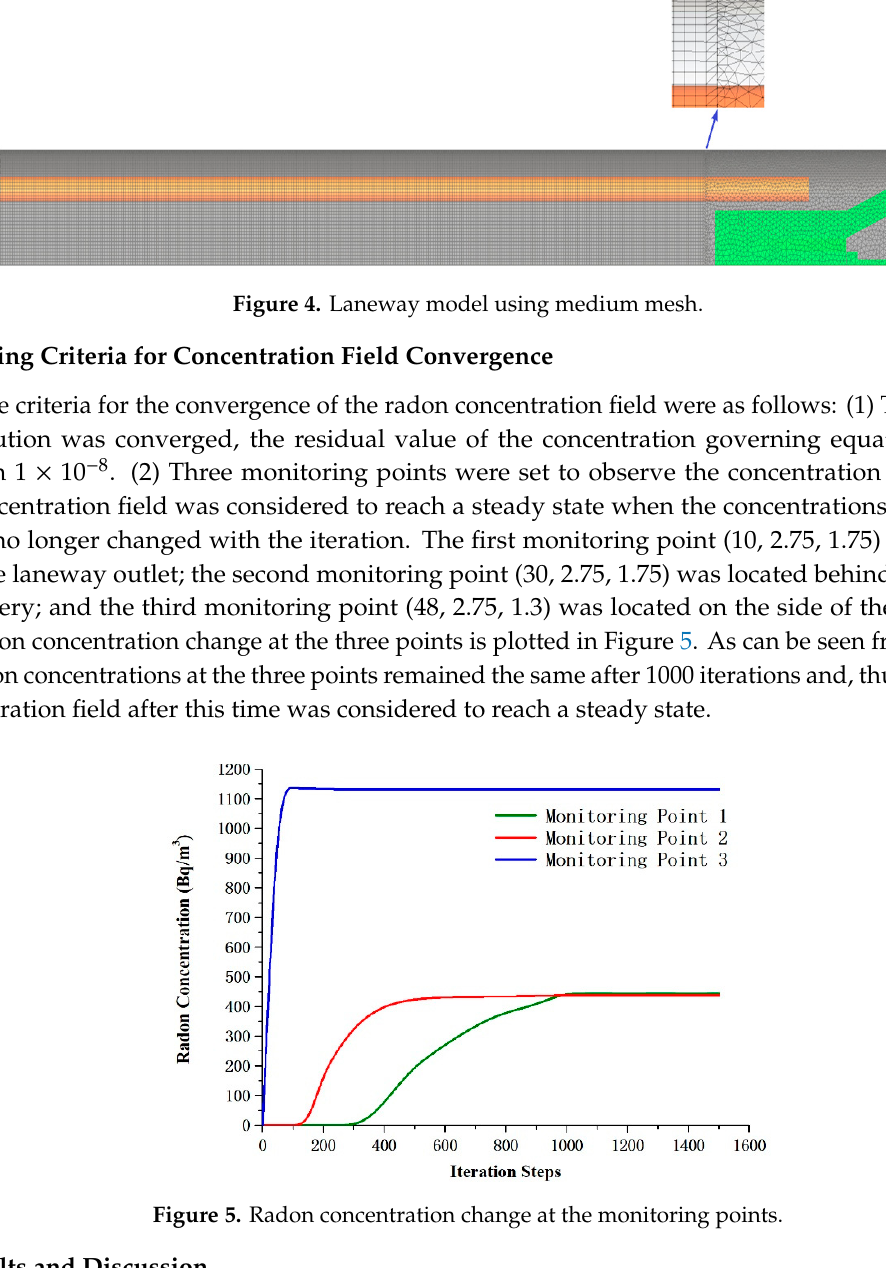
5 of 15 Figure 2. Position of monitoring lines and points. Figure 3. Airflow velocities at monitoring lines.